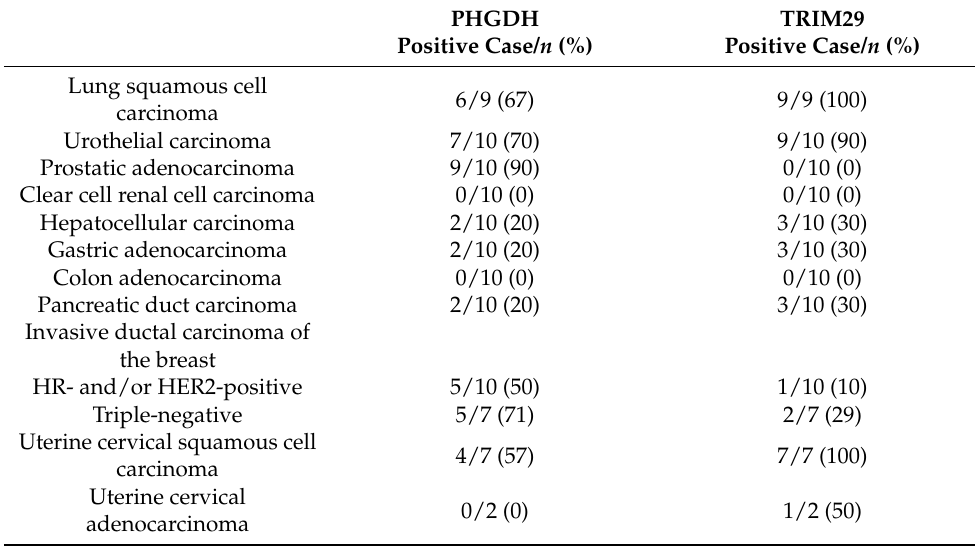
Table 4. Immunohistochemical expression in various tumors